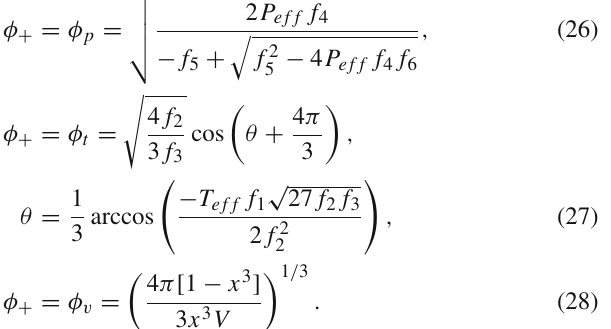
Fig. 3 The pictures of T ef f , + , c with the parameter Q 2 / l 2 = 1 yellow thick line, red thin dashed line, and blue line stand for T ef f , T + , and T c , respectively